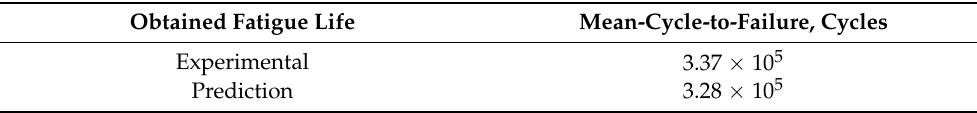
Table 7. MCTF of fatigue data obtained by experiment and prediction.